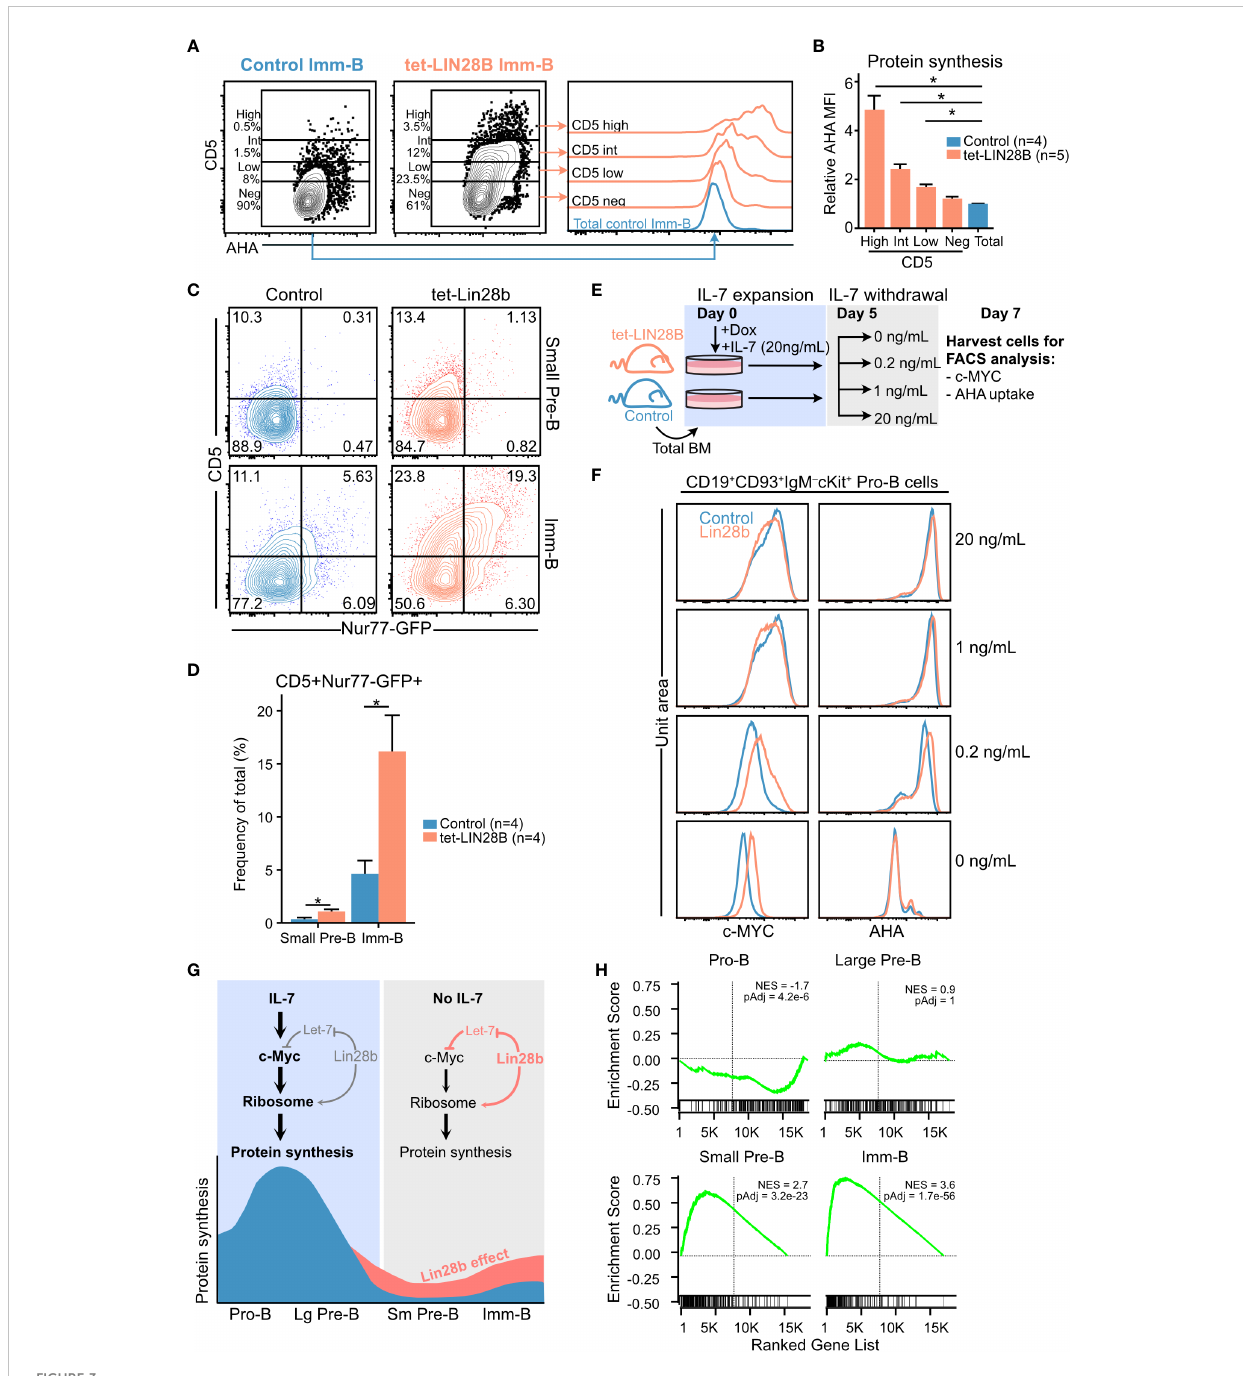
FIGURE 3 Interrogating the stage dependent effects of LIN28B on protein synthesis during B cell development (A) (Left) Representative FACS plots showing CD5 expression in adult Imm-B cells from the indicated genotypes and (right) corresponding AHA uptake of the indicated subsets. (B) AHA MFI within individual CD5 slices, after normalization to AHA MFI in littermate control Imm-B cells. Wilcox test was used to calculate p-values in (B) **p<0.01. Bars show mean ± standard deviation. (C) Representative FACS plot showing CD5 surface expression against Nur77-GFP levels for adult small Pre-B and Imm-B cells of the indicated genotypes. (D) Quanti fi cation of CD5+Nur77-GFP+ cells, as shown in (C) Data from four mice per genotype and two separate experiments. (E) Experimental setup for measuring the impact of IL-7 availability on sensitivity to LIN28B mediated effects on Pro-B cells. Following 5 days of expanding adult B cell precursors in 20 ng/mL IL-7, the cultures were split into conditions with decreasing concentrations of IL-7. Two days later, the cultures were analyzed by FACS for intracellular c-MYC and AHA uptake. (F) Representative FACS histograms for the indicated IL-7 conditions show intracellular staining for c-MYC (left) and AHA uptake (right) in Pro-B cells. (G) Schematic illustration of the proposed LIN28B mode of action on protein synthesis during B cell development. (H) Gene set enrichment analysis (GSEA) of differentially expressed genes between tet-LIN28B induced and control B cell precursor subsets as identi fi ed by RNAseq (See methods). Vertical line indicates Zero cross point. Enrichment for c-MYC target signature version 1 (Hallmark catalog, molecular signature database) is shown. Wilcox test was used to calculate p-values in (B, D) *p<0.05. Bars show mean standard